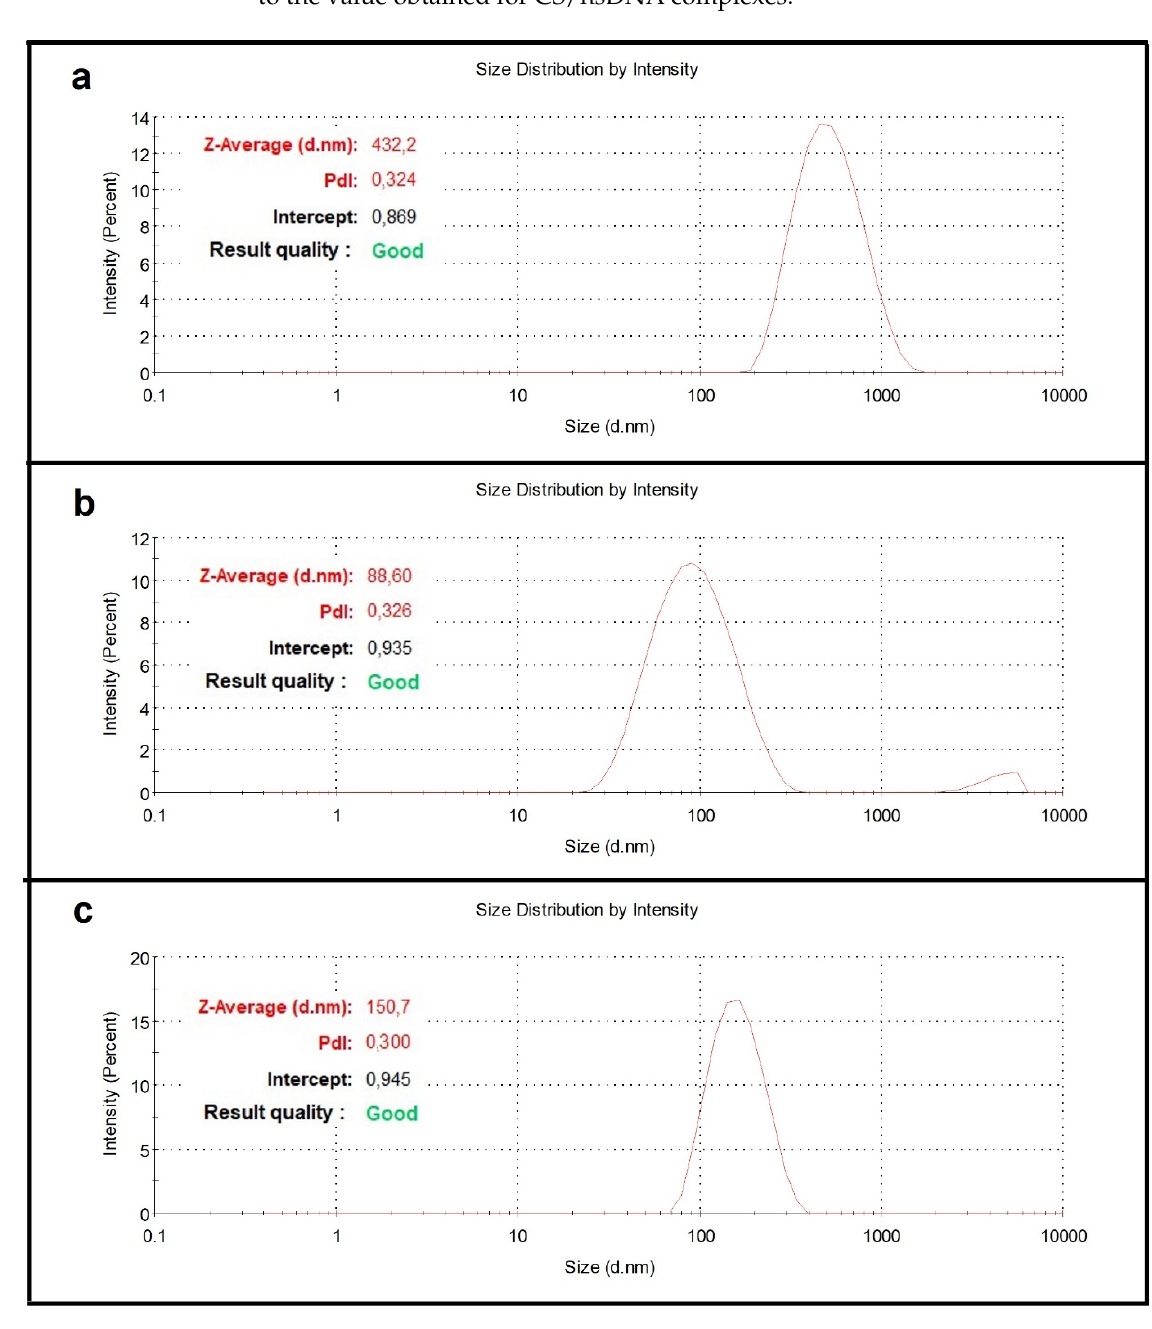
Figure 6. Size distribution by intensity of CS/siRNA ( a ), PEI/siRNA ( b ) and Escort IV TM /siRNA ( c ) complexes. Table 5. Hydrodynamic diameter, PdI, Z-potential and entrapment efficiency (EE) of CS/siRNA tat/rev complexes prepared with CS 50 KDa and N/P = 10.